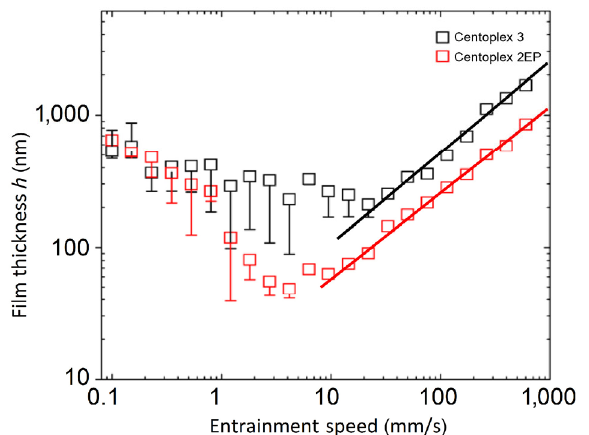
Fig. 1 Schematic diagram of reciprocating motion and trace points. Fig. 2 Central film thickness vs. entrainment